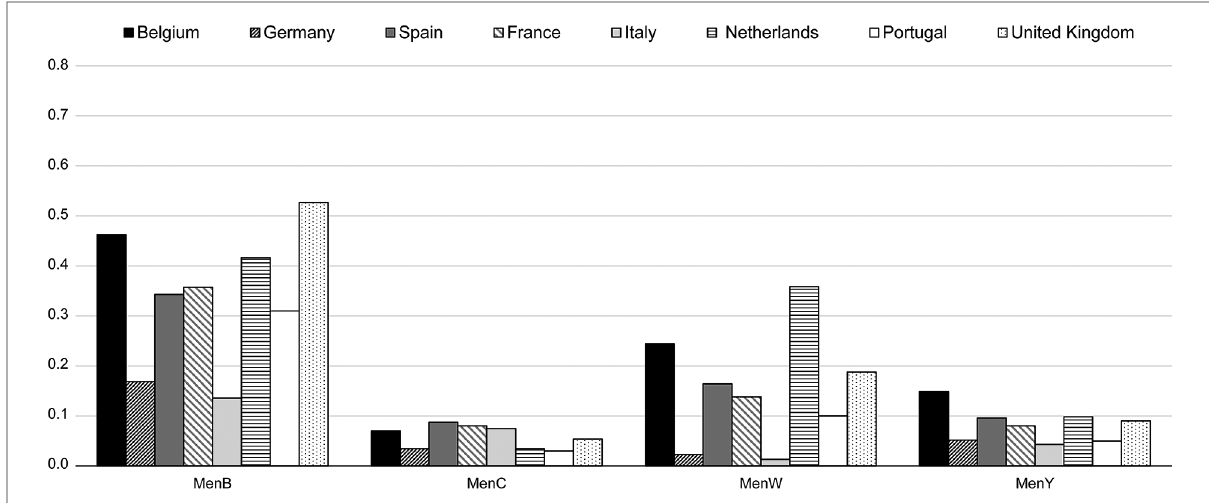
FIGURE 1 Noti fi cation rate of con fi rmed cases* ( N /100,000) by country for each serogroup in 2019 (21). BE, Belgium; DE, Germany; ES, Spain; FR, France; IT, Italy; NL, Netherlands; PT, Portugal; UK, United Kingdom. *Con fi rmed case of IMD is de fi ned as any person meeting at least one of the following laboratory criteria: isolation of N. meningitidis from a normally sterile site, or purpuric skin lesions; detection of N. meningitidis nucleic acid from a normally sterile site, or purpuric skin lesions; detection of N. meningitidis antigen in cerebrospinal fl uid; detection of Gram-negative stained diplococcus in cerebrospinal fl